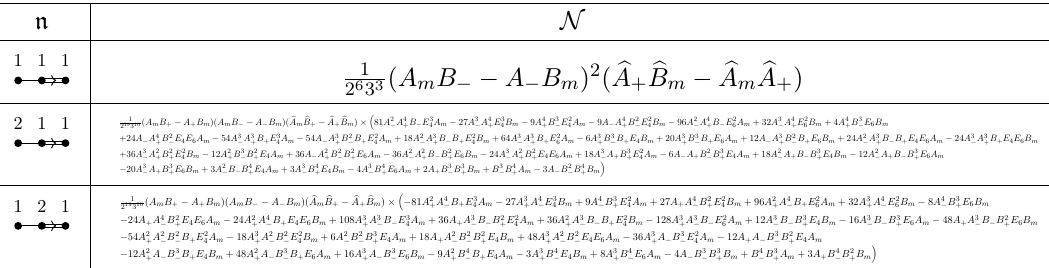
Table 10 . Elliptic genera of B 3 . Here, A z = A z ( τ ) , b A z = A z (2 τ ) , and same for B z . n